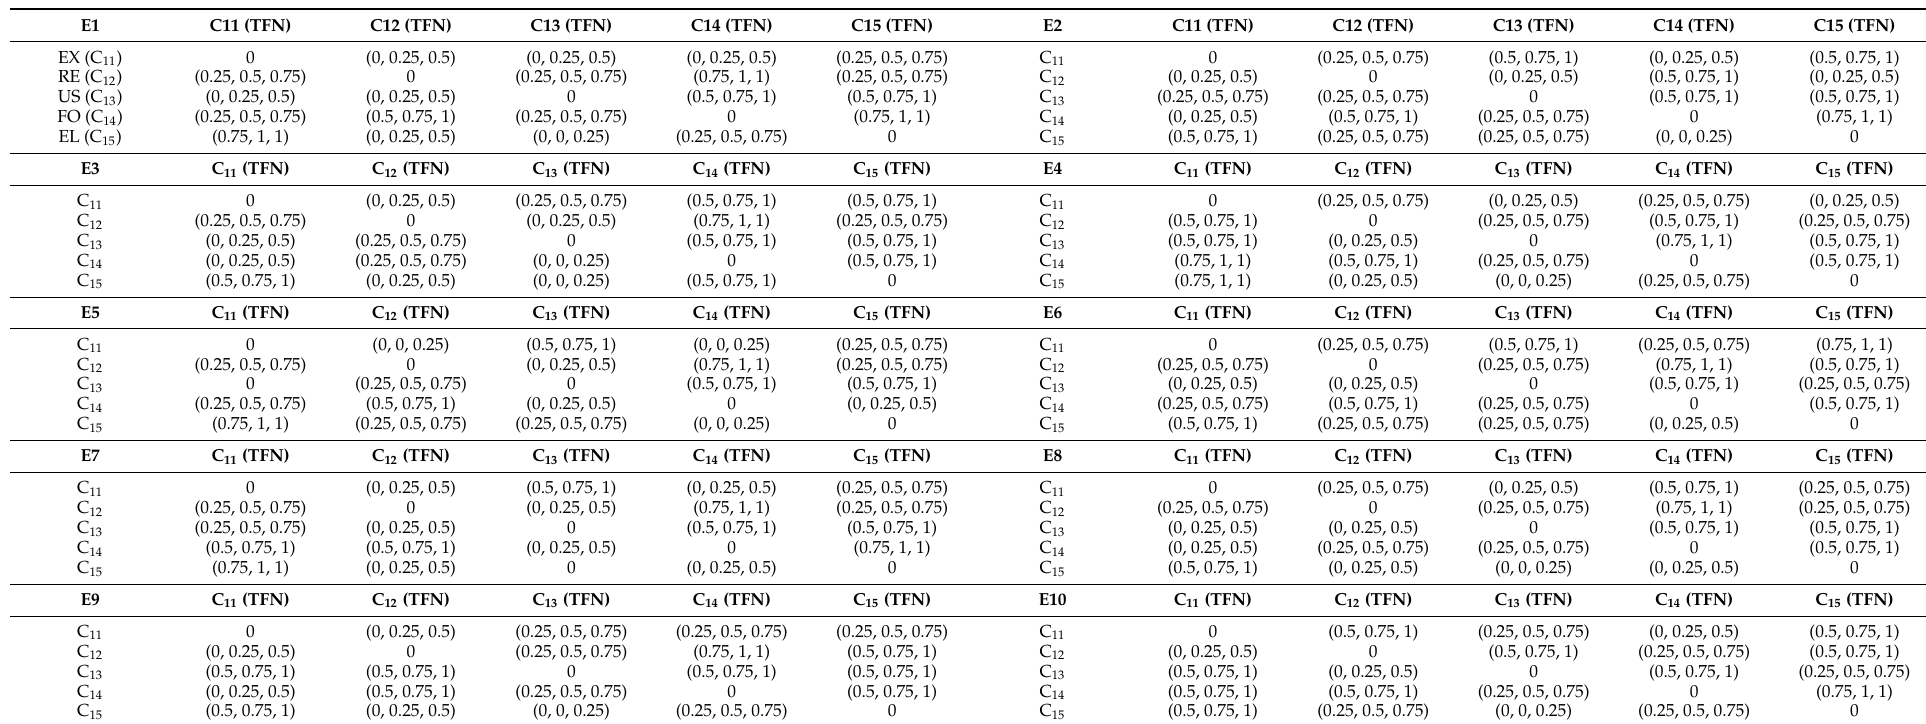
Table A7. The corresponding triangle fuzzy numbers in Table